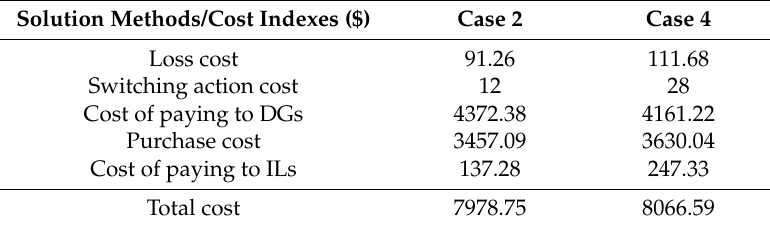
Table 5. Cost comparisons between case 2 and case 4.